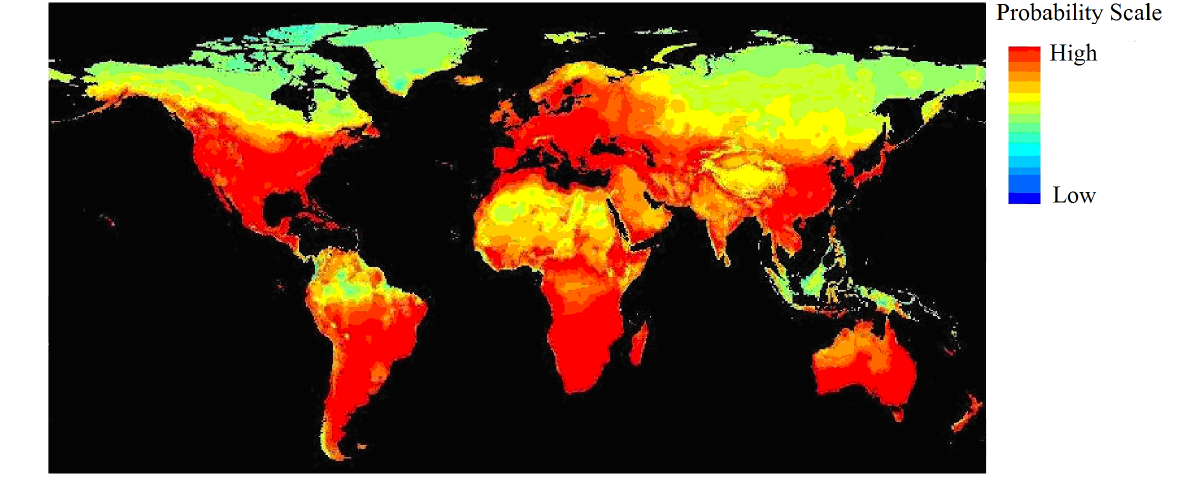
Figure S2. Niche model generated within the old GBIF interface using 19 BIOCLIM factors with 31,873 GBIF records; the climatic suitability appears much too